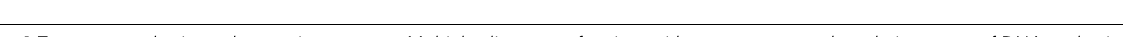
Fig. 4 Teratorn encodes intact herpesvirus genes. a Multiple alignment of amino-acid sequences around catalytic centers of DNA packaging terminase and capsid maturation protease gene in Teratorn ( magenta ), herpesvirus species of Alloherpesviridae ( blue ), Herpesviridae ( orange ), Malacoherpesviridae ( black ) and bacteriophages ( green ). Note the conservation of catalytic residues of terminase (walker A, walker B, C-motif and adenine-binding motif in the ATPase domain ( magenta ), catalytic triads Asp-Glu-Asp in the nuclease domain ( blue )), as well as the catalytic triad of protease (His-Ser-His/Glu; magenta ) 32 in Teratorn . b RT-PCR of Teratorn genes in 5 dpf (days post fertilization) medaka embryos. “ + ” and “–” indicate that the reverse-transcription reaction was carried out or not, respectively. Cycle number of RT-PCR was 40. The colors indicate the categories of genes shown as in Fig. 1 ( red , piggyBac transposase; blue , herpesvirus genes with known funtion; yellow , cellular homologues that seem to be involved in evasion of host immunity (ZFP36-like, CXCR-like and DNA methyltransferase-like) and cell proliferation (CDK-like, pim-like and ZnSCAN-like). c qPCR analysis of Teratorn genes in medaka fi broblast cells administered with or without 2 μ M of 5-azacytidine, 3 mM of N -butyrate and 500 ng/ml of 12- O -Tetradecanoylphorbol 13-acetate (TPA). “ + ” and “–” indicate that each chemical was administrated or not. The value indicates the ratio of molar concentration relative to β -actin. Note that expression levels of most genes were moderately increased by chemical administration, although the expression level was still low. Statistical signi fi cance was tested by one-sided Welch Two Sample t -test. Each data point indicates the raw value of each experiment, and bars represent the mean ± SEM of replicates. Number of biological replicates are as follows; n = 3 for no chemical treatment, n = 3 for 5-azacytidine treatment, n = 4 for